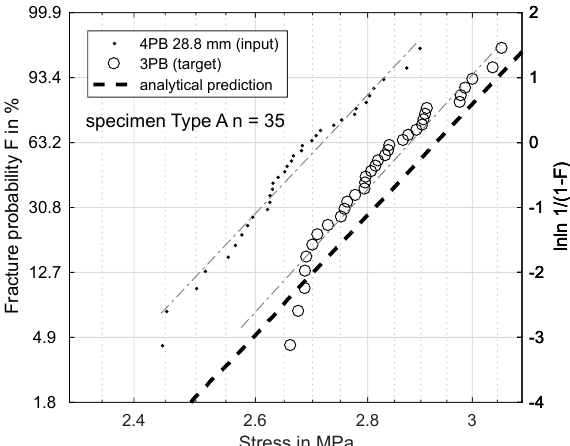
Figure 7. Specimen Type A: prediction of fracture probability from 4PB (28.8 mm) to 3PB.